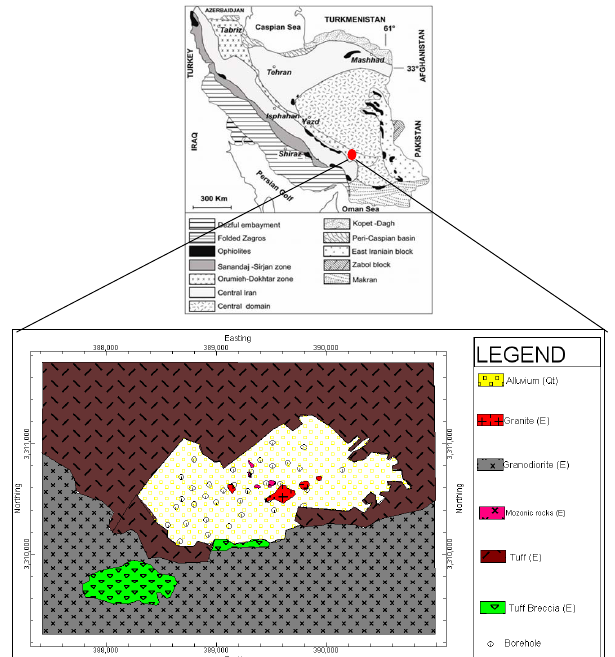
Fig. 1. Location of Nowchun Cu-Mo porphyry deposit in Urumieh-Dokhtar magmatic belt modified based on Alavi (1994) and simplified geological map of Nowchun deposit and its boreholes locations.